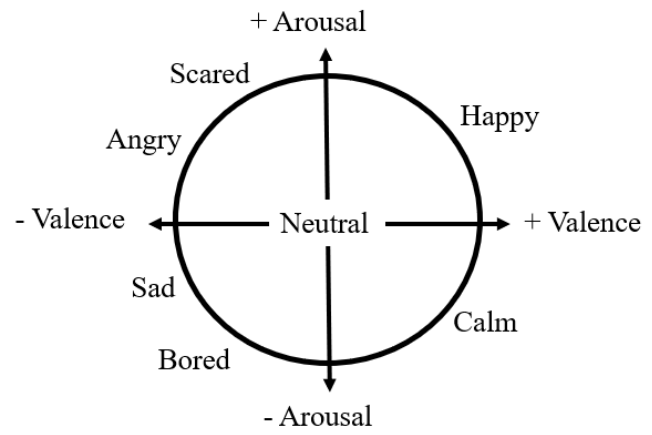
Figure 2. Valence-Arousal emotional